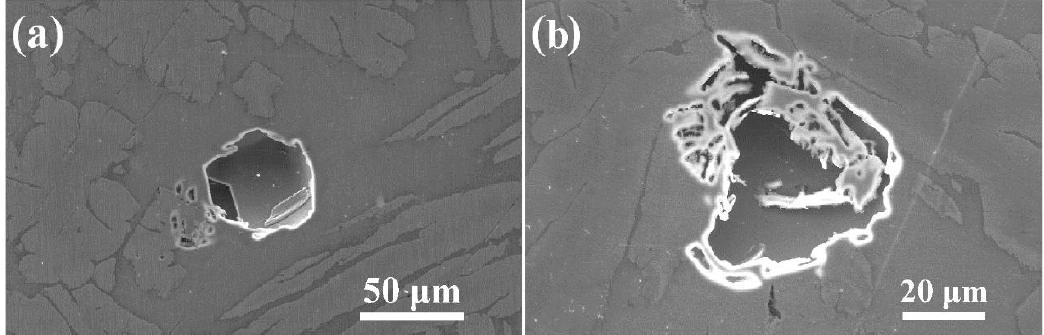
Figure 5. SEM pitting morphologies of specimens with different heat inputs after the CPT tests: ( a ) 5 kJ/cm; ( b ) 15 kJ/cm.